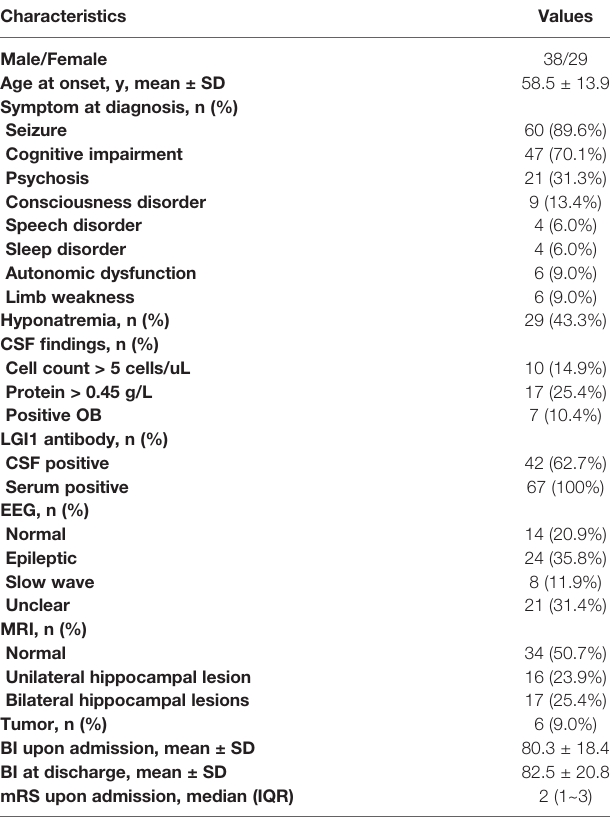
TABLE 1 | Patient characteristics (N =